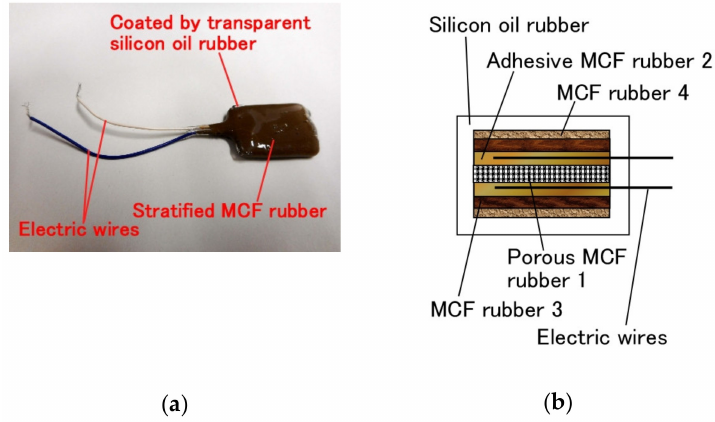
Figure 22. Specimen of the consummate MCF rubber sensor by the production process of Figure 21: ( a ) photograph; ( b ) schematic cross section.